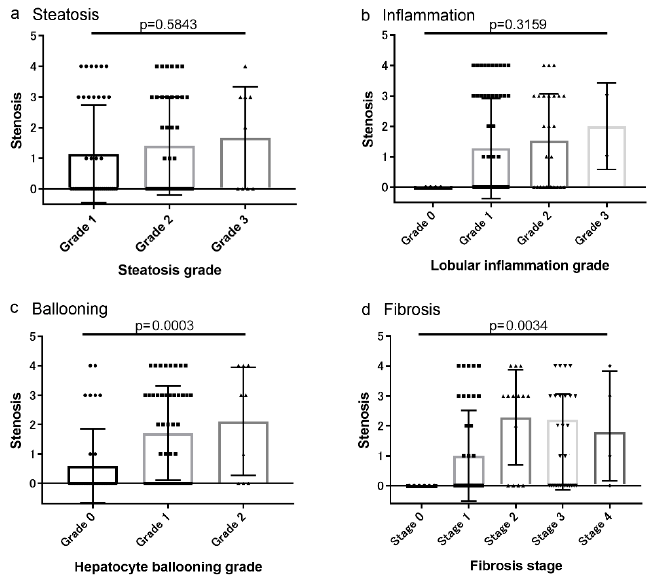
Figure 2. Association between the grade of coronary artery stenosis (CAS) and the histologic characteristics ( a ) Steatosis, ( b ) inflammation, ( c ) Ballooning, and ( d ) Fibrosis. The CAS grade was positively correlated with the hepatocyte ballooning grade and the stage of liver fibrosis.